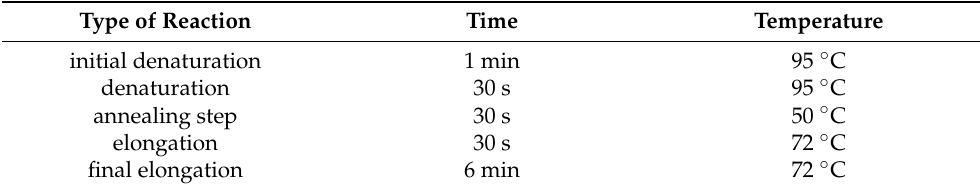
Table 2. Thermal profile of the second, nested amplification reaction (40 cycles from 2 to 4). Type of Reaction Time Temperature initial